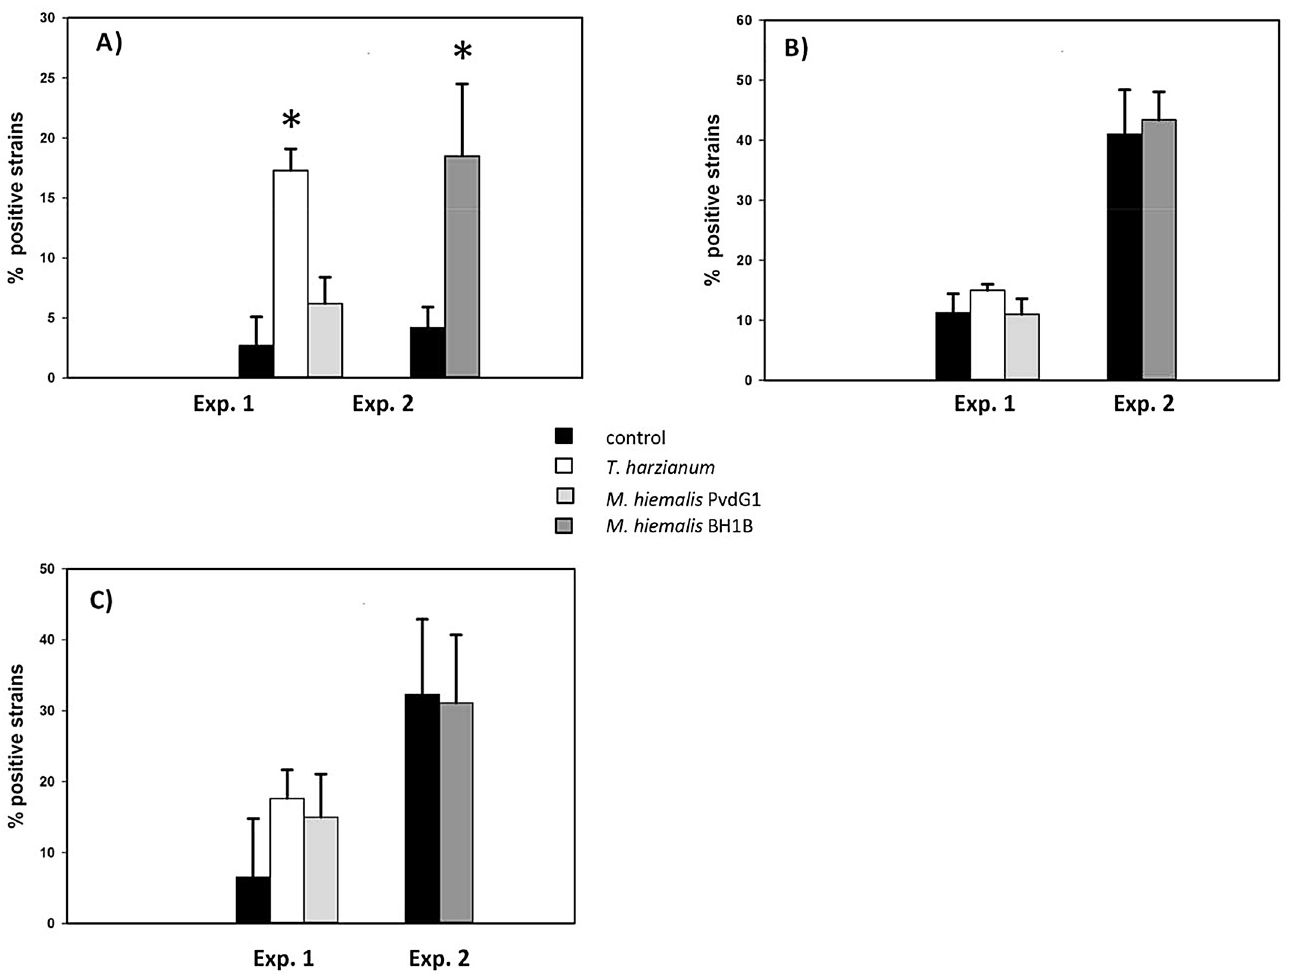
Fig 3. Percentage of rhizosphere bacterial isolates positive for different enzyme activities. Bacterial isolates were obtained from root-adhering soil after 6 weeks of growth of Carex arenaria seedlings in quartz sand microcosms. * indicates significant difference (p < 0.05) between microcosms with and without pre-inoculation of fungi. Note that experiment 1 and 2 started with different bacterial inoculums as indicated in Material & Methods. Data are the averages of three randomly selected sand microcosms. Error bars represent standard deviation. For each microcosm 40 bacterial isolates were individually screened for the different enzyme